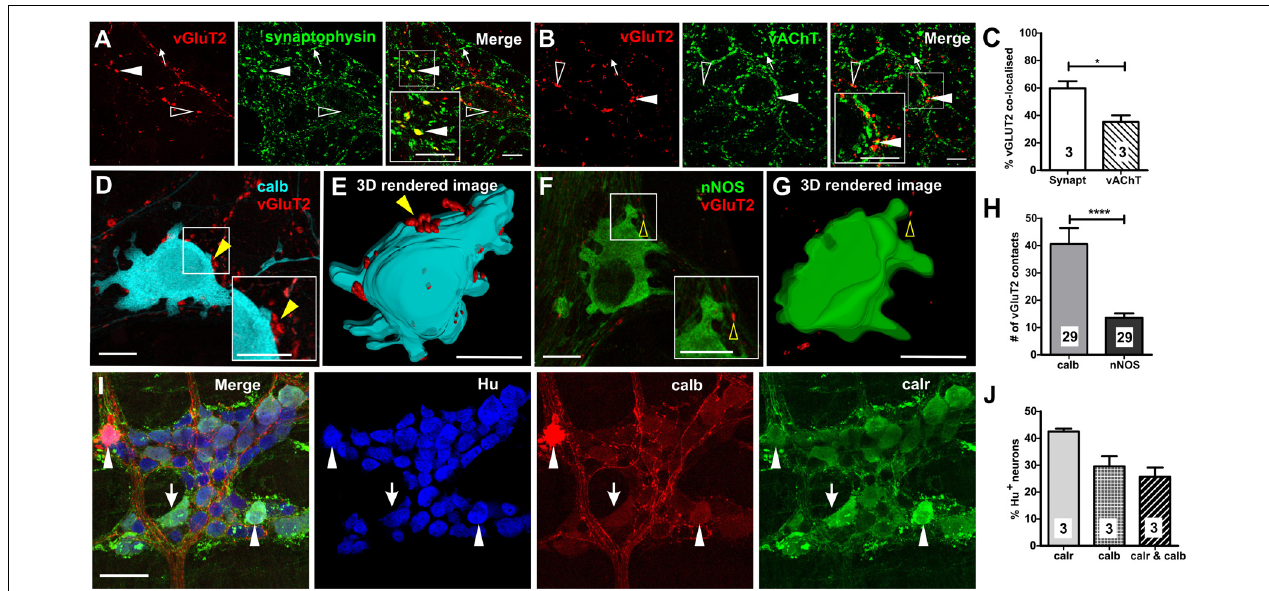
FIGURE 1 | Expression of vGluT2 in the myenteric plexus of mouse distal colon. (A,B) High-resolution micrographs illustrating vGluT2 (red), synaptophysin (green), and vAChT (green) immunoreactive varicosities within the myenteric plexus of mouse colon. Scale bars = 10 µ m. (A) Several vGluT2 immunoreactive varicosities contain synaptophysin (filled arrowhead) but some lack synaptophysin (open arrowhead). Some synaptophysin varicosities lack vGluT2 (arrow). (B) Some vGluT2 varicosities contain vAChT (filled arrowhead), but most vGluT2 varicosities lack vAChT (open arrowhead). Likewise, many vAChT varicosities do not express vGluT2 (arrow). (C) Histogram showing the percentage of vGluT2 varicosities co-localized with synaptophysin and with vAChT. A significantly higher percentage of vGluT2 varicosities contain synaptophysin compared to those containing vAChT. Numbers on the bar graphs indicate numbers of animals examined. Fluorescence images (D,F) and 3D rendered surfaces (E,G) of vGluT2 varicosities (red) with a calb+ neuron (D,E) (pseudo colored cyan) and a nNOS+ neuron (F,G) (green) shows vGluT2 varicosities contacting the calb+ (yellow filled arrowheads) but not the nNOS+ neuron (yellow open arrowheads). All scale bars = 10 µ m. (H) Histogram illustrating the number of vGluT2 varicosities contacting calb neurons and nNOS neurons. Calb neurons receive significantly more vGluT2 immunoreactive varicosities compared to nNOS neurons. Numbers on the bar graphs indicate numbers of neurons examined. (I) Flurorescence micrograph of the myenteric plexus from the distal colon of a C57Bl/6 mice stained for calb (red), calr (green), and pan-neuronal marker Hu (blue). Some calb neurons lack calr (open arrowheads), some calr neurons lack calb (arrows) and some Hu+ neurons contain both calb and calr (filled arrowheads). Scale bar = 50 µ m. (J) Histogram showing the proportions of calr and/or calb+, Hu+ neurons in the myenteric plexus. Numbers on the bar graphs indicate number of animals examined. ∗ p < 0.05, ∗∗∗∗ p -value < 0.0001; unpaired t